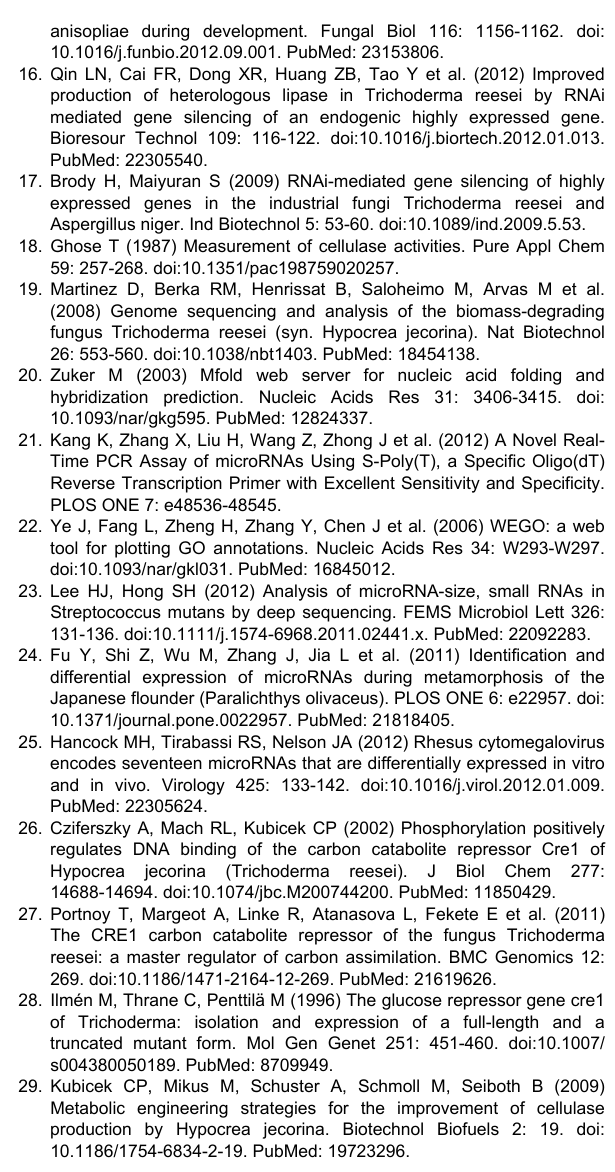
Table S1. Primers used in S-Poly(T) RT-qPCR assay. (XLS) Table S2. Measurement of T. reesei total RNA.